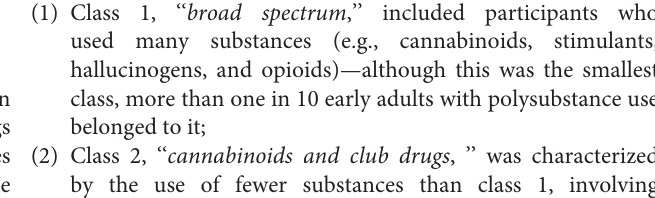
95% CI = 8.78–24.88). These findings show that, once initiated, polysubstance use is often continued over